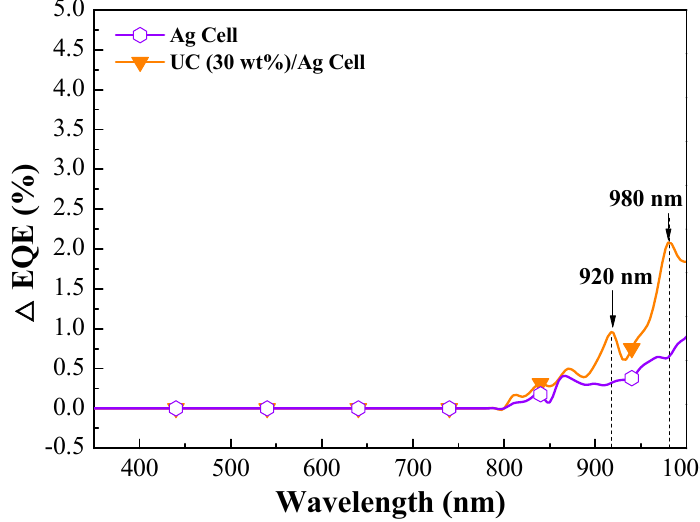
Figure 11. EQE enhancement ( ∆ EQE ) of ( a ) reference cell with Ag reflector relative to that of the reference cell (violet line) and ( b ) UC / Ag cell at a phosphor concentration of 30 wt% relative to that of the reference cell (orange line).